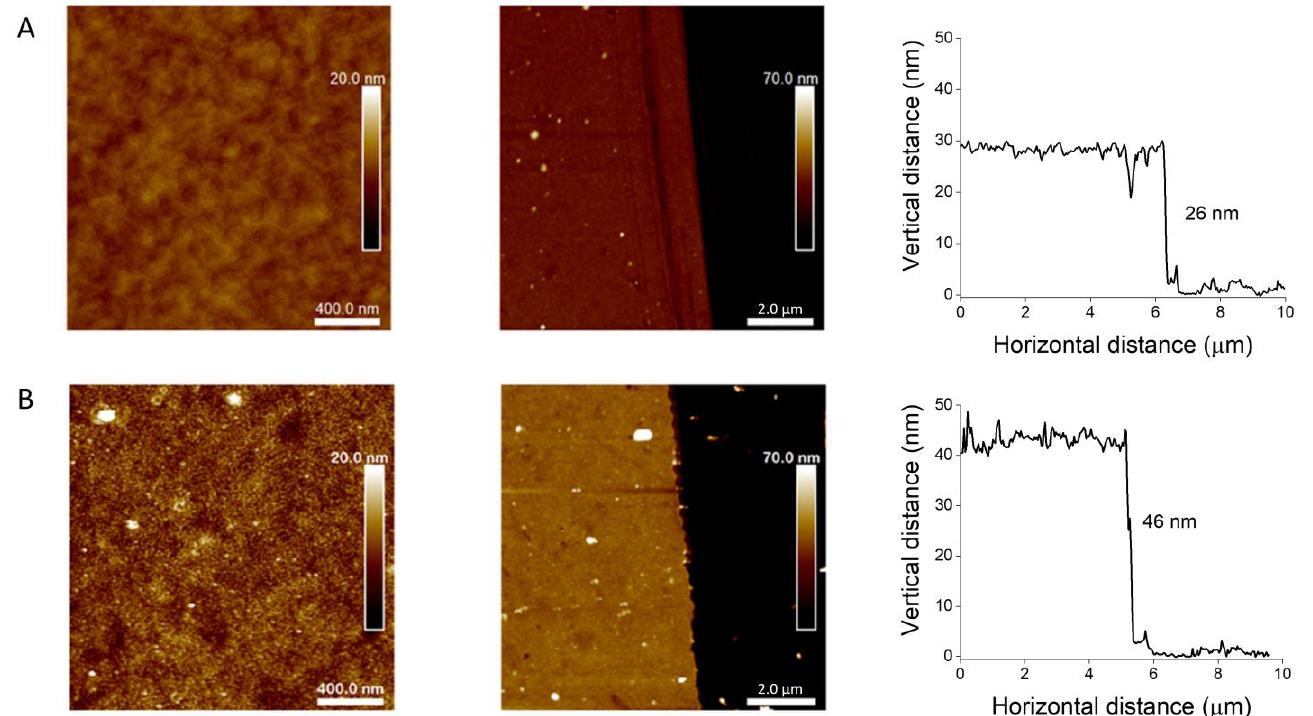
Figure 5. AFM topography images of ProDOT-Poly(MM) ( A ) and Poly(ProDOT)-Poly(MM) ( B ) brushes with corresponding representative cross-section profiles.